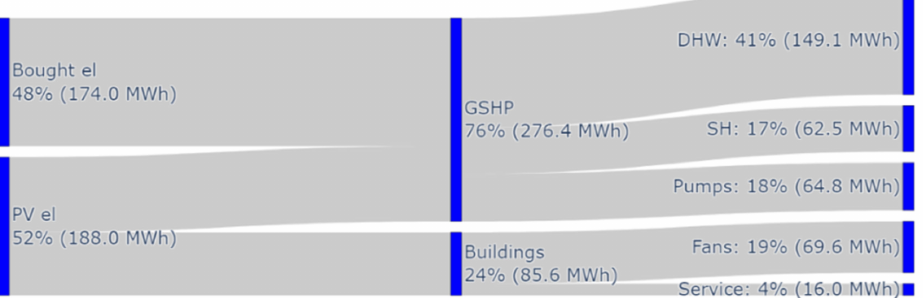
Figure 19. Net energy flows in Testbed EM over 12 months, excluding user direct electricity use. The quota of electricity that is actually self-consumed is not specified in this